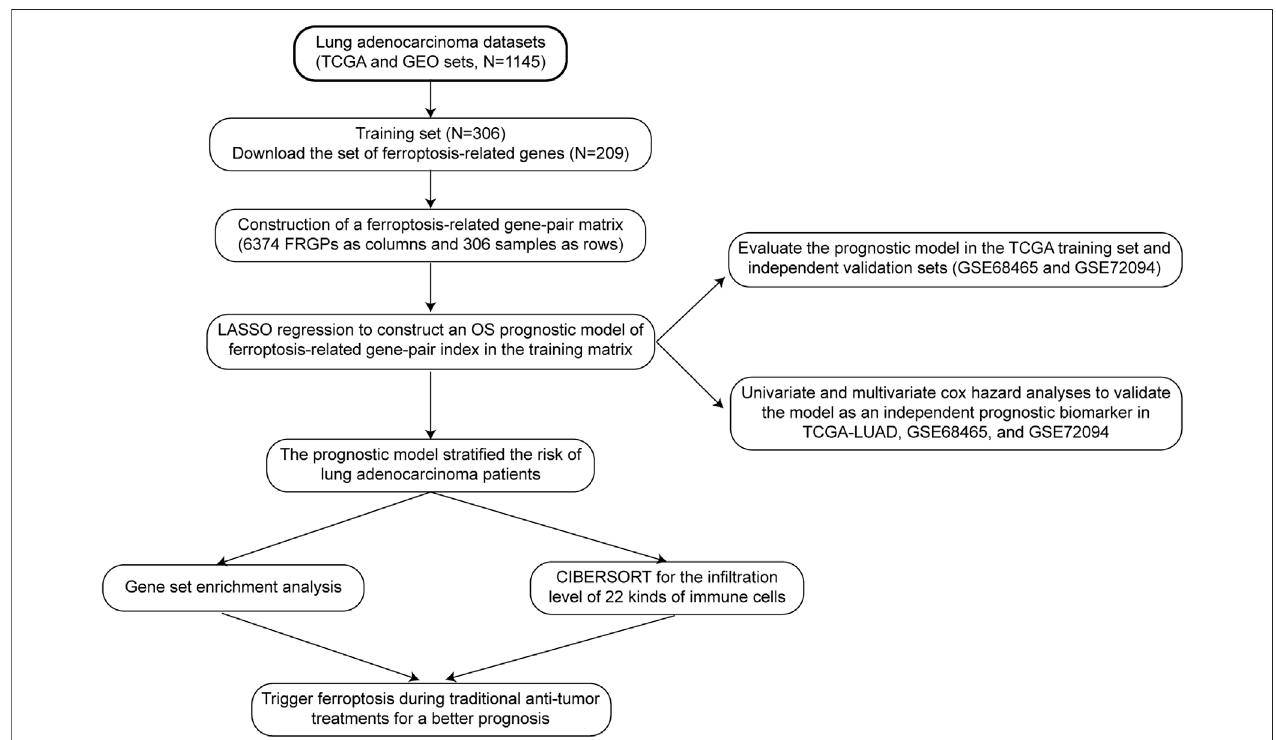
FIGURE 1 | Data processing and research